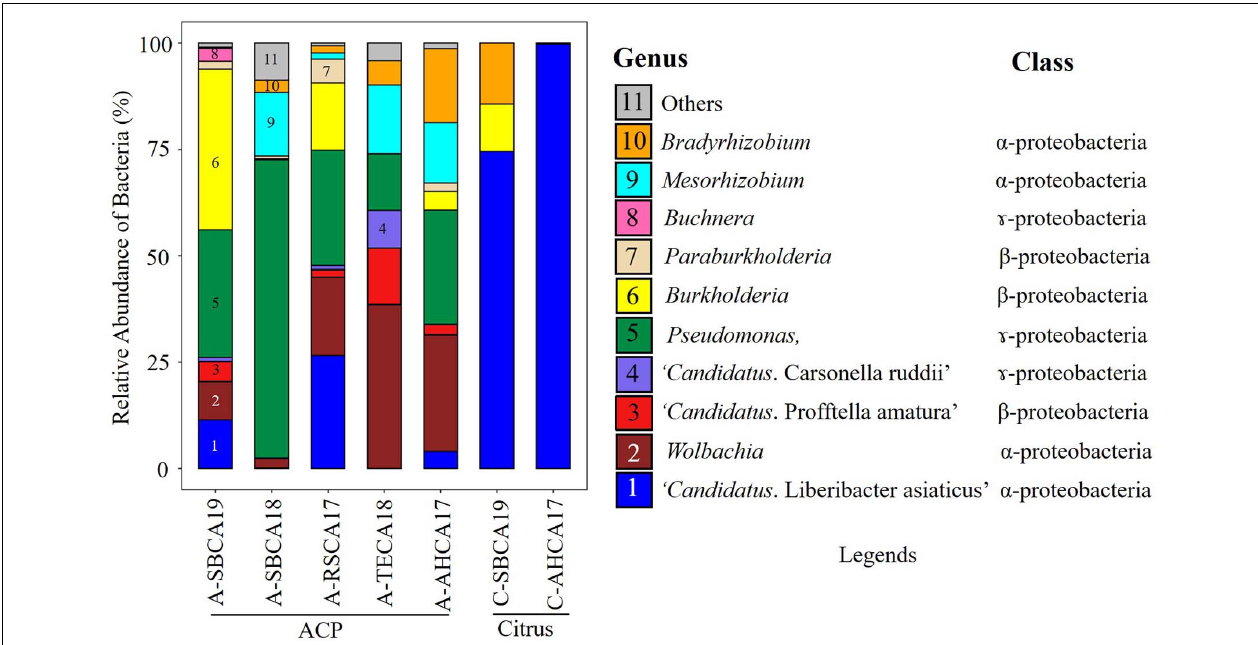
FIGURE 1 | Relative abundance of bacteria (%) in Asian citrus psyllid (ACP)/citrus samples from southern California. The relative abundance was calculated based on the Kaiju classification of top 10 ranked genera from de novo assembled (MEGAHIT) contigs filtered by mitogenome, chloroplast genome (citrus only), and host genome. Bacterial names were coded with colors and numbers along with their class and shown in legends.